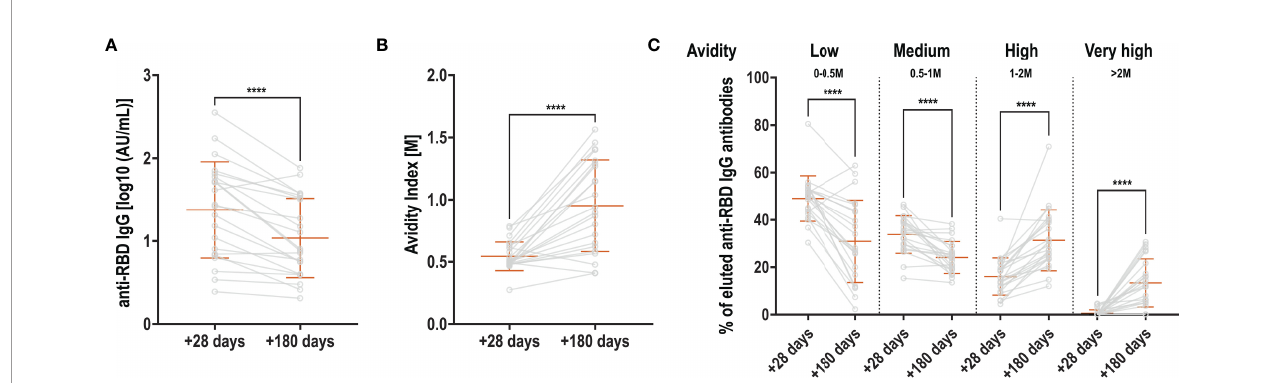
FIGURE 3 | Evolution of RBD-speci fi c antibodyavidity. (A) Anti-RBDantibodies at +28 and+180 days, expressed inlog10-transformed AU/mL (B) Avidity index: molarity of thiocyanate for which 50% of the antibodies dissociatedat+28 and +180 days (C) Aviscan: proportion ofantibodies with low (0-0.5M), medium (0.5-1M), high (1-2M) and very high (>2M) avidity at +28 and +180 days. Orange bars represent mean + SD. Light grey lines connectsamples fromthe samepatient (grey circles).Two-sided paired t- test (A + B) or Wilcoxon matched-pairs signedrank test (C) were used to calculate signi fi cance for comparisonsbetween timepoints